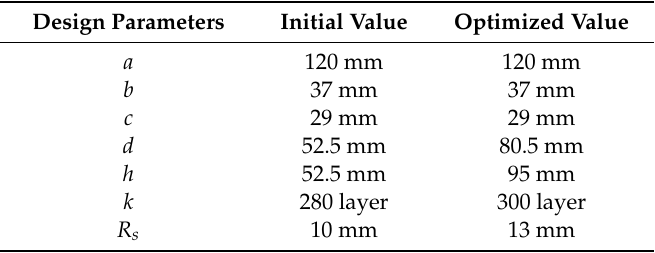
Table 4. Initial and optimized value of design